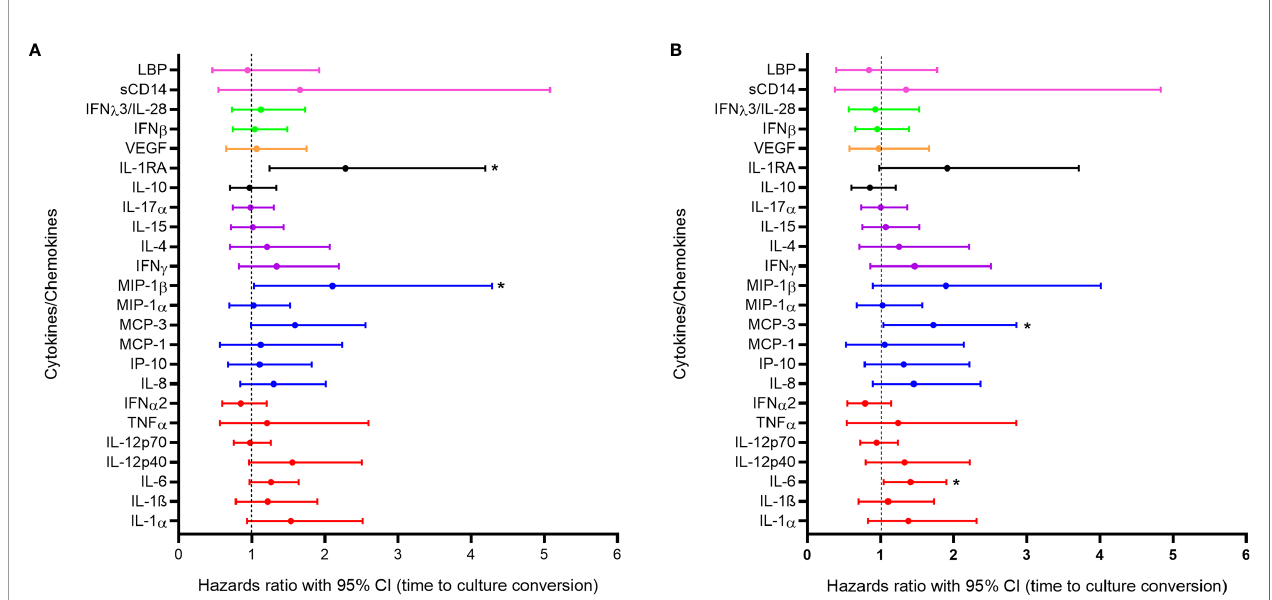
FIGURE 2 | Association between cytokine/chemokine expression measured at active TB and time to culture conversion (n=132) in (A) bivariable and (B) multivariable models. Individual associations are shown between time to fi rst negative TB culture result and pro-in fl ammatory cytokines (red), chemokines (blue), adaptive response cytokines (purple), anti-in fl ammatory (black), growth factors (orange), interferons (green) and plasma biomarkers (pink) with error bars depicting 95% con fi dence intervals. The dotted line at 1 distinguishes the hazards ratio of higher than 1 (to the right) indicating shorter time to culture conversion and lower than 1 (to the left) indicating longer time to culture conversion. Asterisk indicates signi fi cant associations (p <